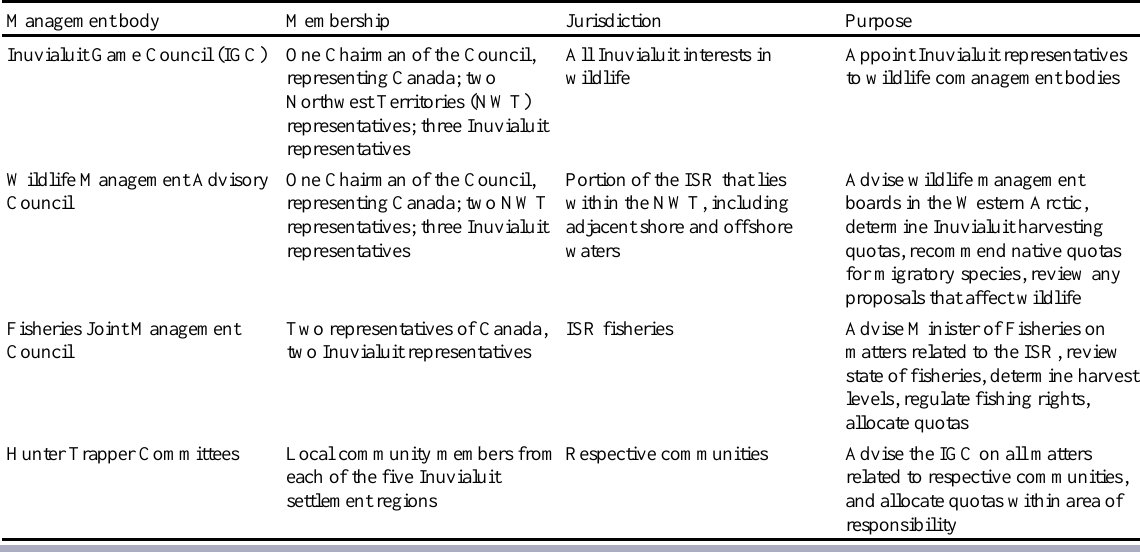
Table 3 . Nested governing bodies and their presence in the Inuvialuit Settlement Region (ISR) (Department of Indian and Northern Affairs Canada 1984). Management body